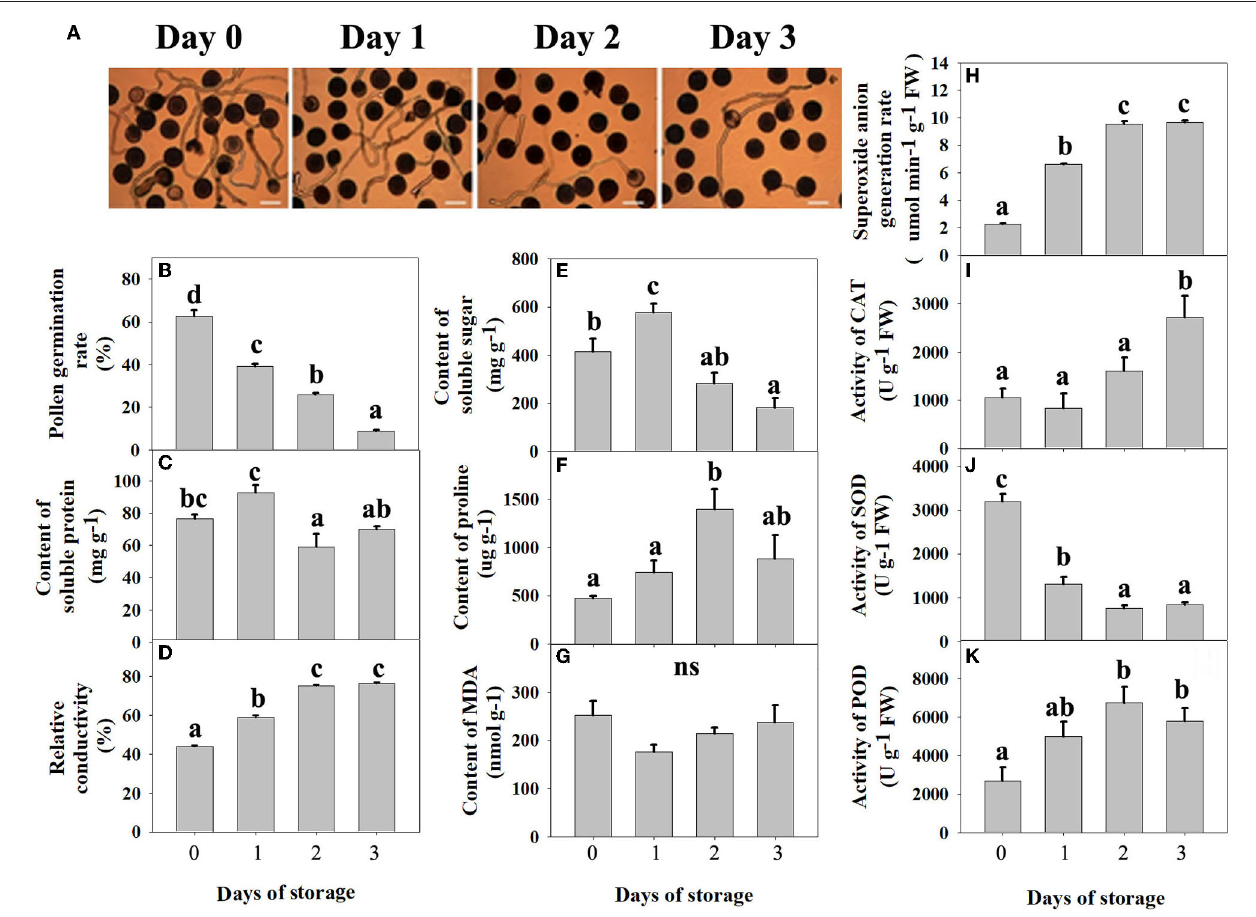
FIGURE 1 | Physical and chemical changes in pitaya pollen during low-temperature storage. (A) Microscopic examination of pollen germination from days 0 to 3. The observation was conducted under a microscope (200 × ) in the open field. Three fields were observed in each sample, and three replicates were measured. Bars represent 100 µ m. (B) In vitro pollen germination rate. (C) Content of soluble protein. (D) Relative conductivity. (E) Content of soluble sugar. (F) Content of proline. (G) Content of manlondialdehyde (MDA). (H) Superoxide anion generation rate. (I) The activity of catalase (CAT). (J) The activity of superoxide dismutase (SOD). (K) The activity of peroxidase (POD). In (B–K) , each bar was the mean ± standard error of three replications, and bars with different letters were significantly different at P < 0.05 using the independent samples